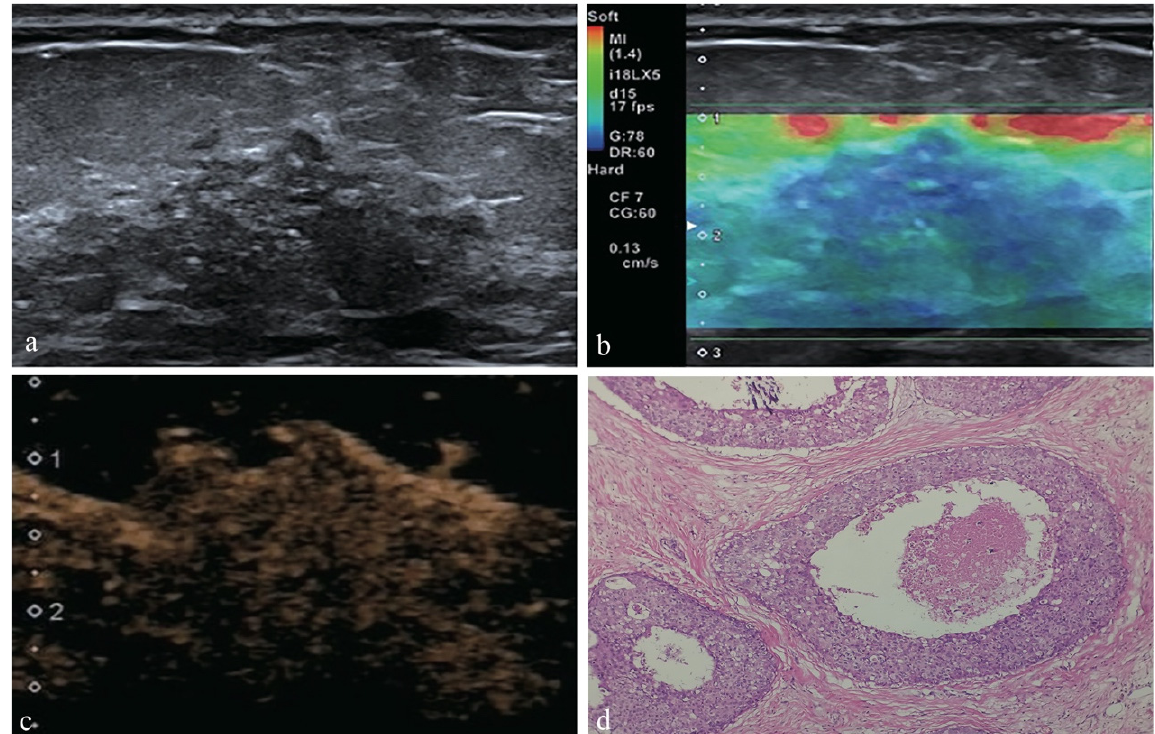
Figure 1. Conventional US images of a 45-year-old female who was diagnosed with DCIS by surgical excision. ( a ) The B-mode US image shows a 37.0 mm non-mass breast lesion with microcalcifications in the outer upper quadrant area next to the nipple of the right breast (arrows); ( b ) The color Doppler US image shows abundant blood supply.